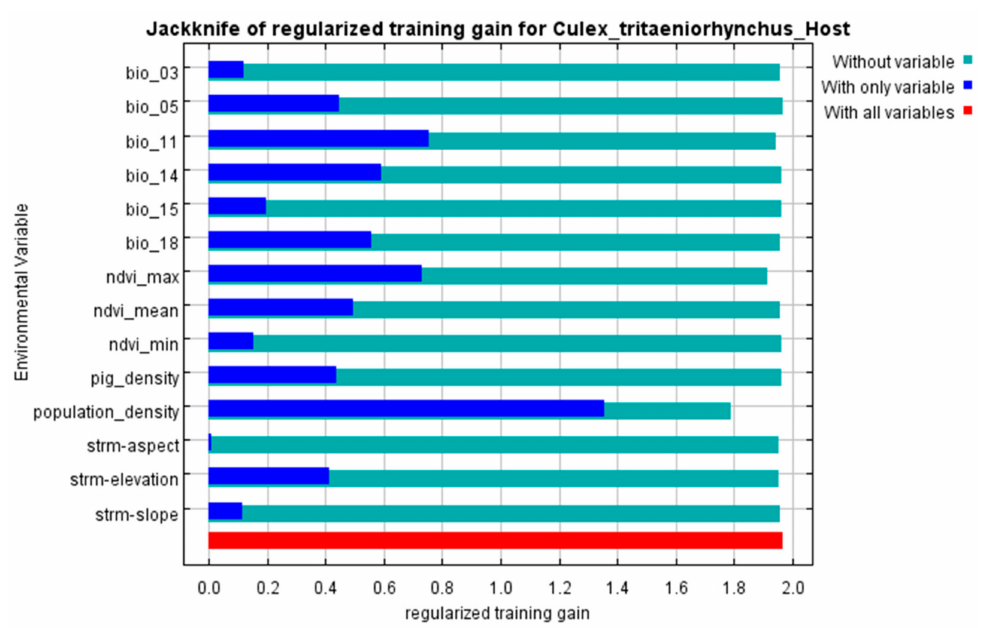
Figure 4. Results of the jackknife test for the “Host” model. A longer blue bar indicates a greater importance of that variable when it was used alone. A shorter green bar indicates a greater reduction in training gain when that variable was omitted.